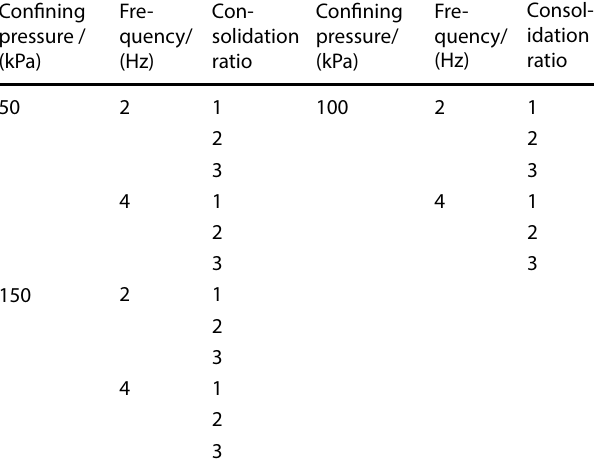
Table 6 Dynamic test